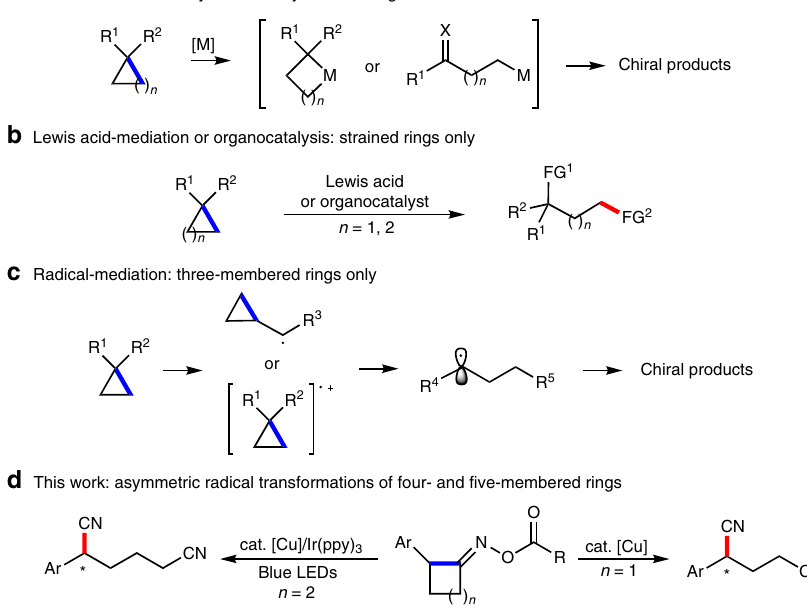
Fig. 1 Enantioselective functionalization via ring-opening C − C bond cleavage. a Transition-metal-catalysis: normally strained rings. b Lewis acid-mediation or organocatalysis: strained rings only. c Radical-mediation: three-membered rings only. d This work: asymmetric radical transformations of four- and fi ve- membered